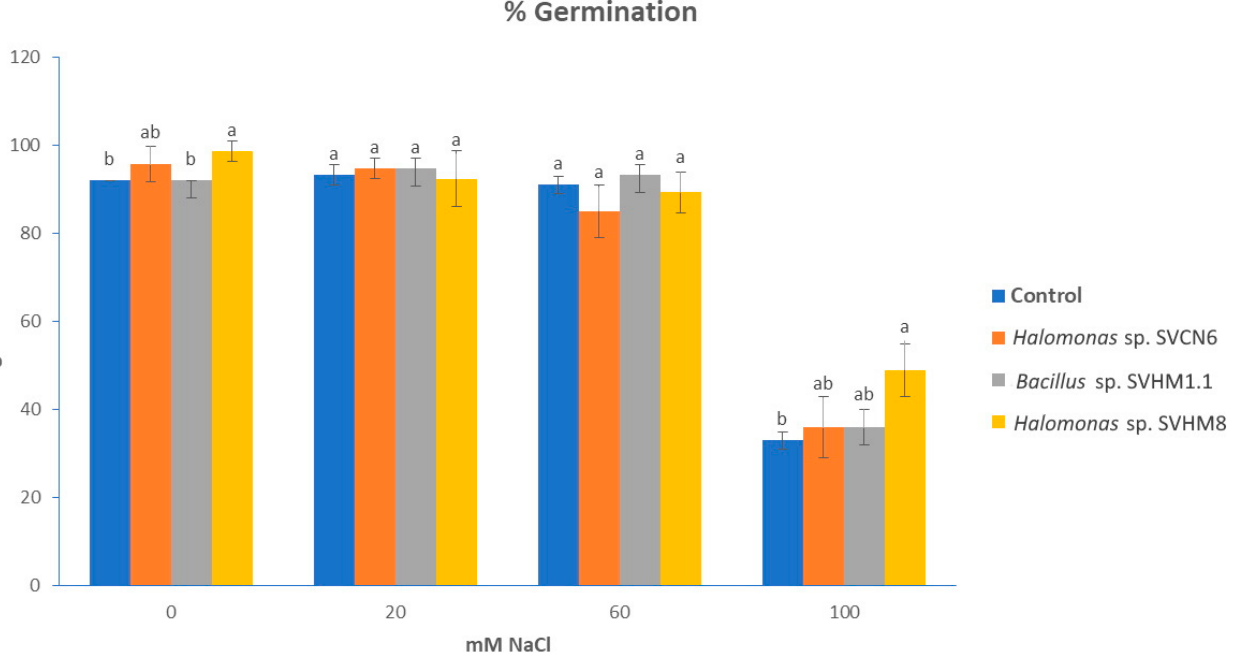
Figure 3. Effect of halophilic bacteria with growth promoting characteristics on Solanum lycopersicum germination. The y-axis shows the percentage of germination, and the x-axis indicates the salinity levels in mM (millimoles) of NaCl. Statistical analysis was performed comparing treatments at each salinity level. Bars indicate standard error; different letters at each salinity level indicate significant differences between treatments, Tukey’s test ( p ≤ 0.05).